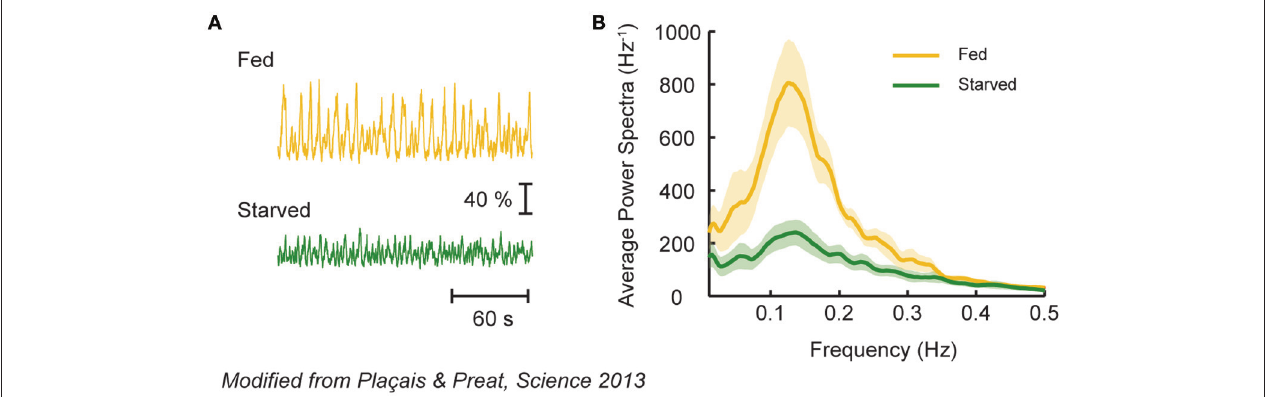
FIGURE 3 | MV1 and MP1 DAN activity represents nutritive state of a fly. (A) Spontaneous calcium fluctuation of MV1 and MP1 DANs in fed or starved flies after spaced conditioning using electric shocks and odors. Strong calcium oscillation is observed in fed (yellow), but not in starved (green), flies. (B) Average power spectra of the spontaneous DAN activity in fed or starved flies. Fed flies exhibit a characteristic peak, revealing an oscillatory behavior that is absent in starved flies. Modified from Plaçais and Preat (2013) with a